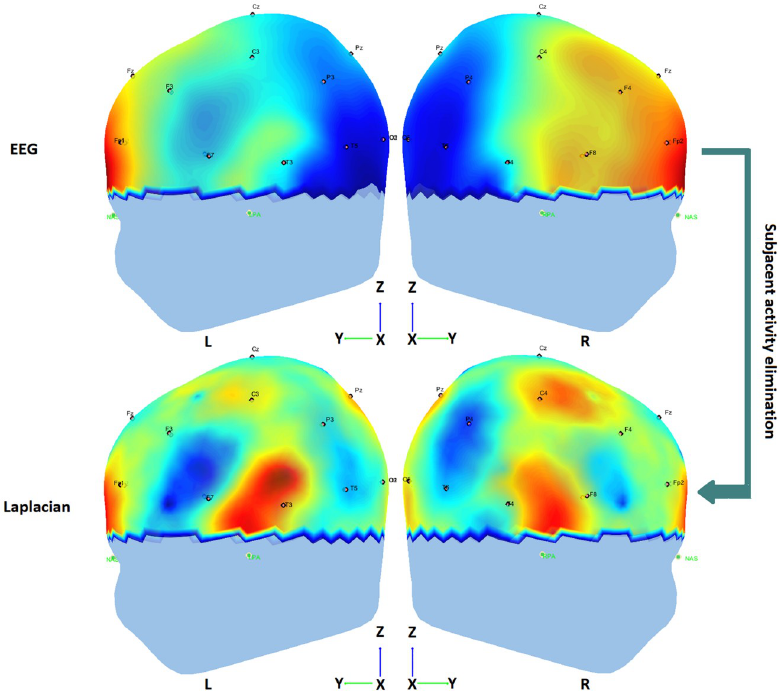
Fig 2. Graphic representation of the effect of Laplacian spatial filtering in one high-achievement subject during task onset.